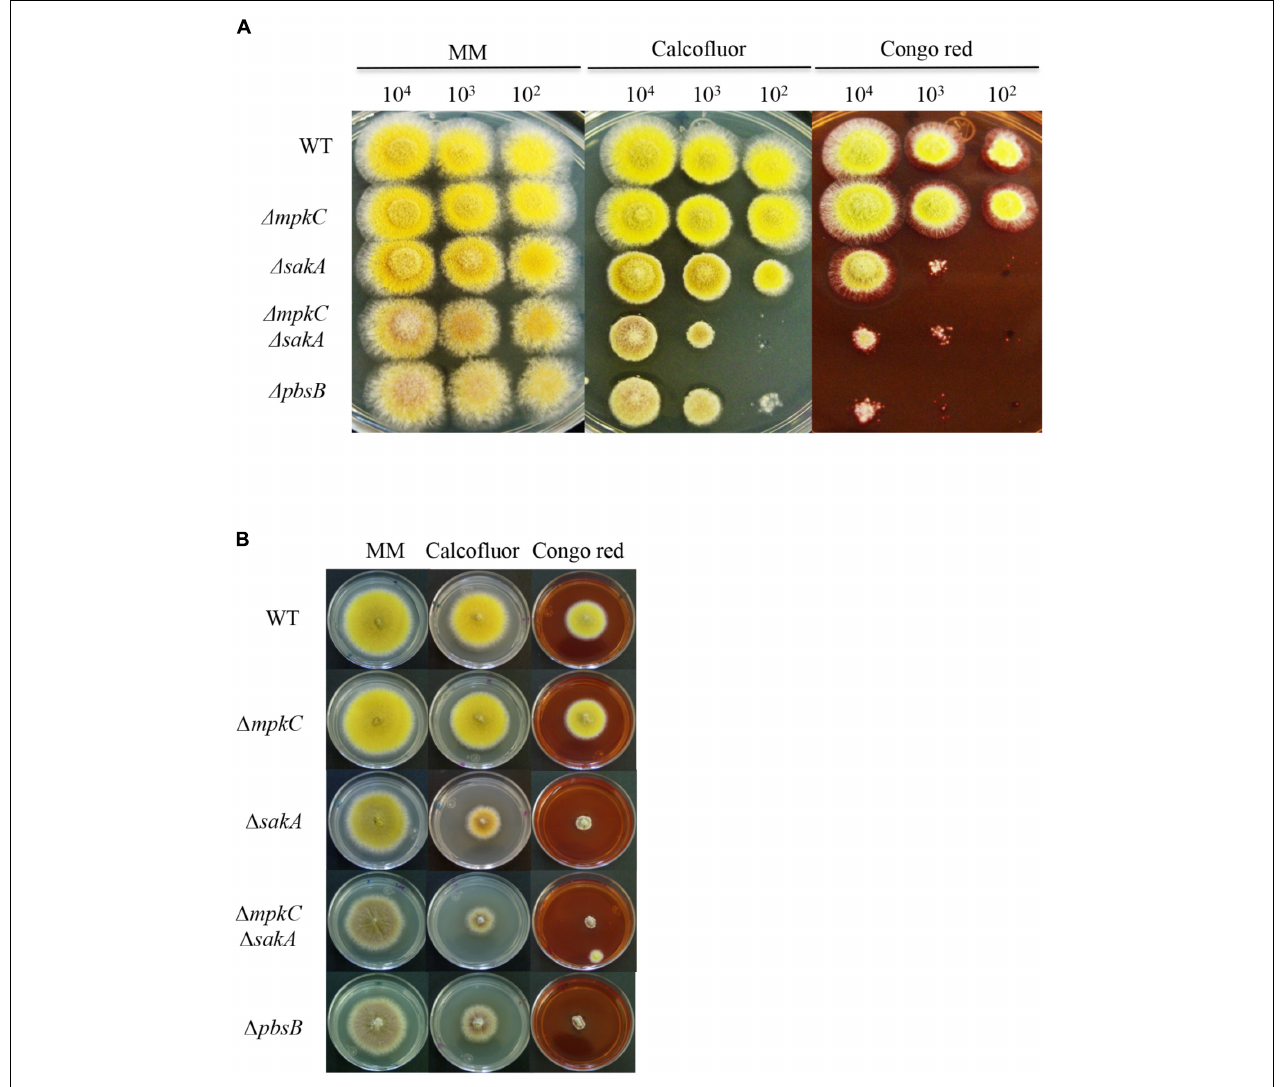
FIGURE 2 | SakA and MpkC inactivation results in sensitivity to cell wall damaging in conidia and mycelia. (A) Spores (1 × 10 4 ) from strains CLK43 (WT), COS0020 (cid:49) mpkC ( (cid:49) mpkC ), CRJ1 ( (cid:49) sakA ), CRJ11 ( (cid:49) mpkC (cid:49) sakA) and COS (cid:49) pbsB05 ( (cid:49) pbsB ) were inoculated on supplemented MM plates containing cell wall damaging compounds Calcofluor (20 µ g/ml) or Congo red (30 µ g/ml) and incubated at 37 ◦ C for 2 days. (B) Mycelial plugs cut from the growing edge of 5-day colonies from strains CLK43 (WT), COS0020 (cid:49) mpkC ( (cid:49) mpkC ), CRJ1 ( (cid:49) sakA ), CRJ11 ( (cid:49) mpkC (cid:49) sakA ), and COS (cid:49) pbsB05 ( (cid:49) pbsB ) were transferred to plates containing Calcofluor (20 µ g/ml) or Congo red (30 µ g/ml) and incubated at 37 ◦ C for 4